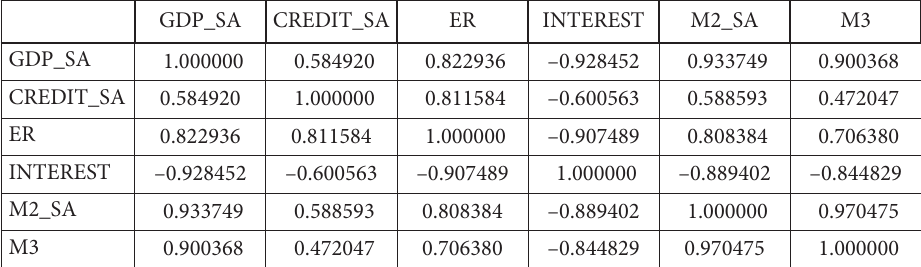
Table 1. Correlation matrix of the variables for Romania (source: authors’ calculations) GDP_SA CREDIT_SA ER